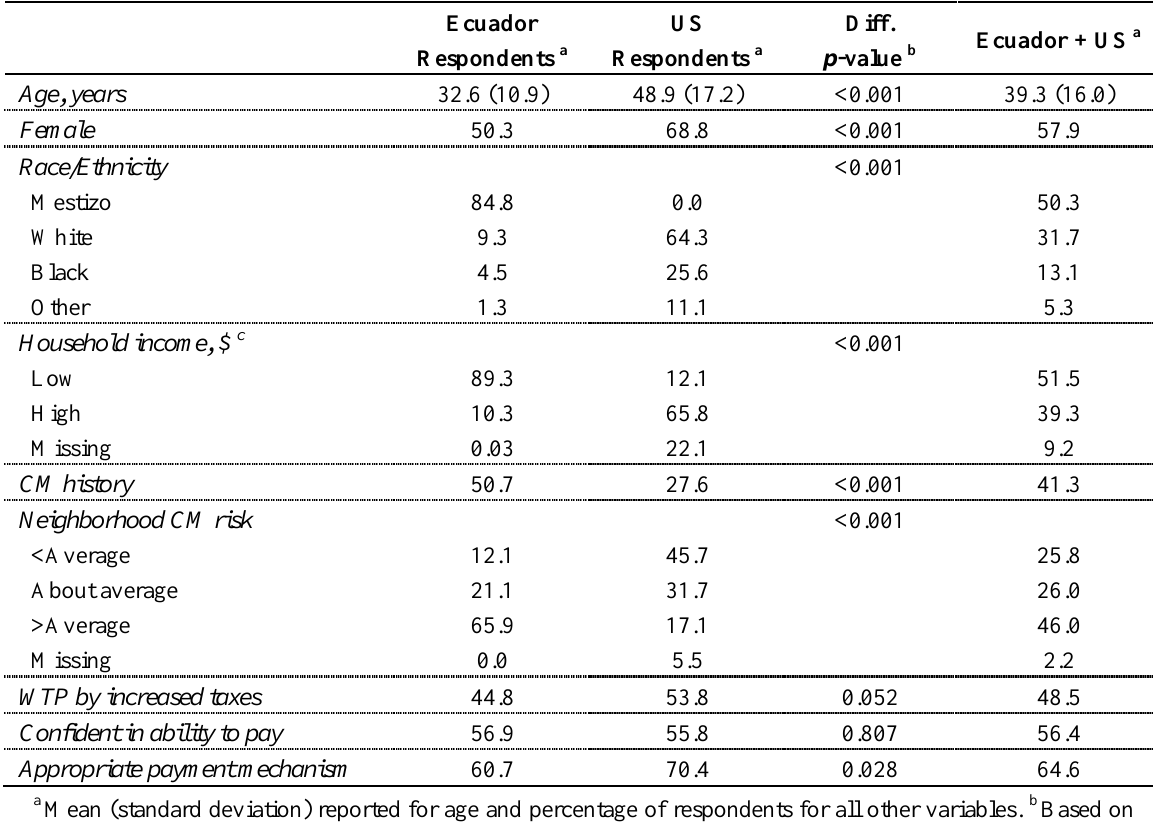
Table 1. Respondent Demographics: Ecuador (N = 290), United States (N = 199) and Combined, Ecuador and United States (N =